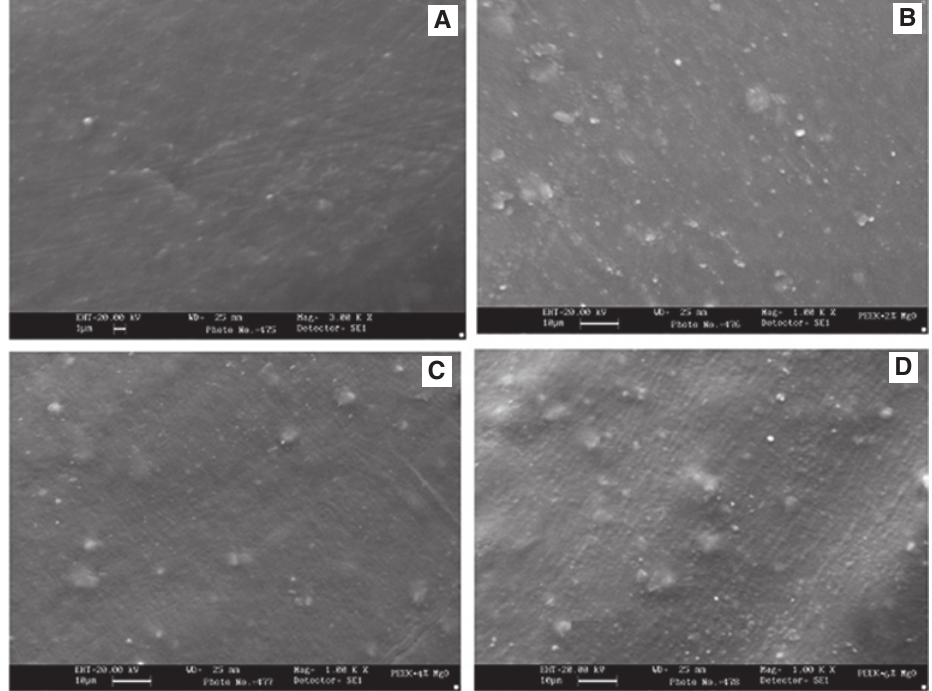
Figure 2: SEM images of PAEK-MgO nanocomposites: (A) 0 wt%, (B) 2 wt%, (C) 4 wt% and (D) 6 wt% of MgO nanoparticles.